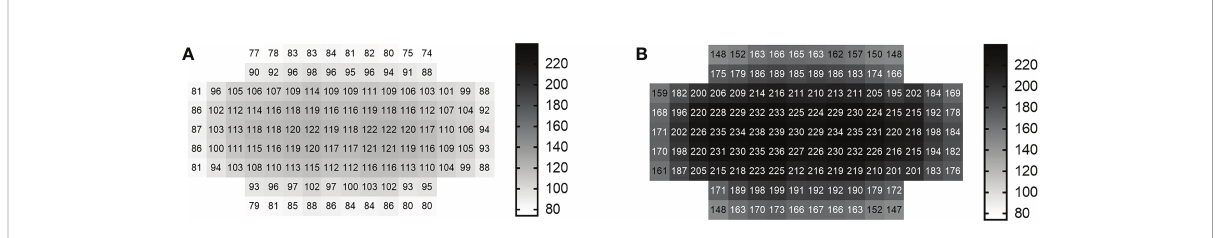
FIGURE 1 Light intensity distribution underneath each LED light treatment 1 . (A) Low light intensity treatment (I Low ), (B) High light intensity treatment (I High ) 1 Each heat map depicts the photon fl ux densities ( PFD s) between 400 and 780 nm [µmol m -2 s -1 ] measured every 100 cm 2 within one experimental block (1.2 m 2 ) underneath the light treatments at cultivation table level ( n = 120 measurements). Gray scales to the right of each light distribution pattern are scaled from minimum to maximum PFD s (74-239 µmol m -2 s -1 ) measured across both light